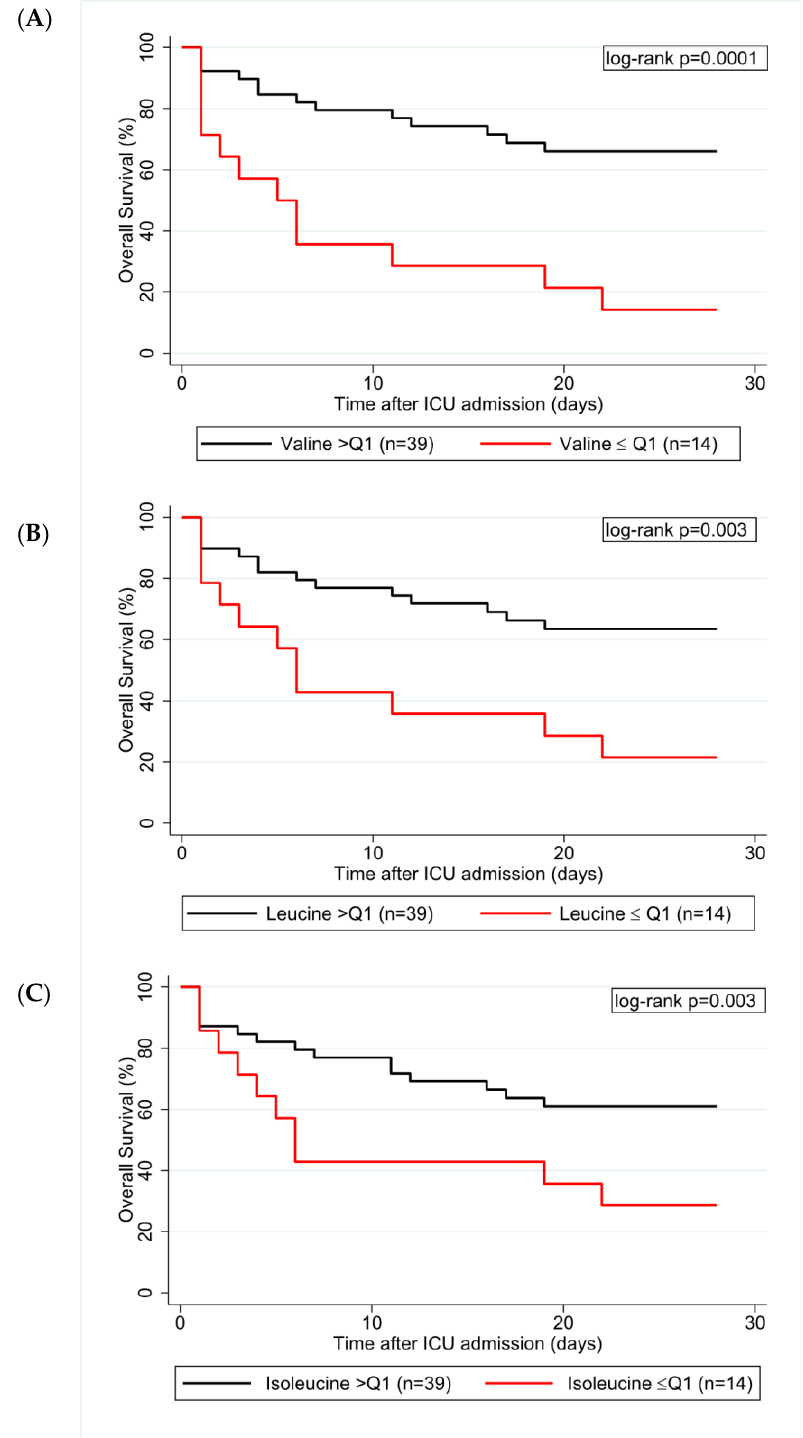
Figure 3. Kaplan–Meier estimates for valine ( A ), leucine ( B ), and isoleucine ( C ). The Q1, i.e., the 25th percentile, corresponds to a cutoff value for valine, leucine, and isoleucine of 33.3, 44.1, and 13.7 NSI units, respectively. The 28-day Kaplan–Meier survival estimates for patients below or above the respective cutoff were 14% vs. 66% for valine, 21% vs. 64% for leucine, and 29% vs. 61% for isoleucine. Abbreviations: Q1 = 25th percentile of the respective branched-chain amino acid, ICU = intensive care unit.